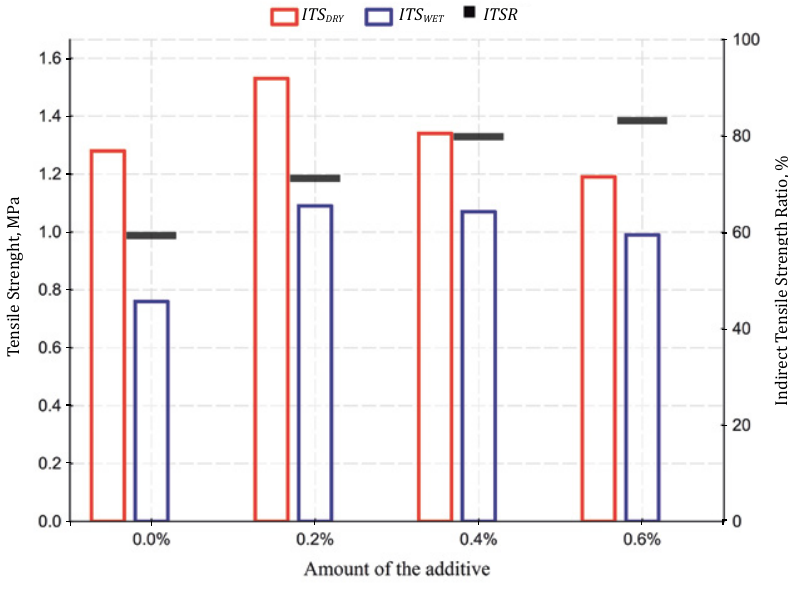
Figure 17. The effect of rejuvenator on the Indirect Tensile Strength and sensitivity to water determined